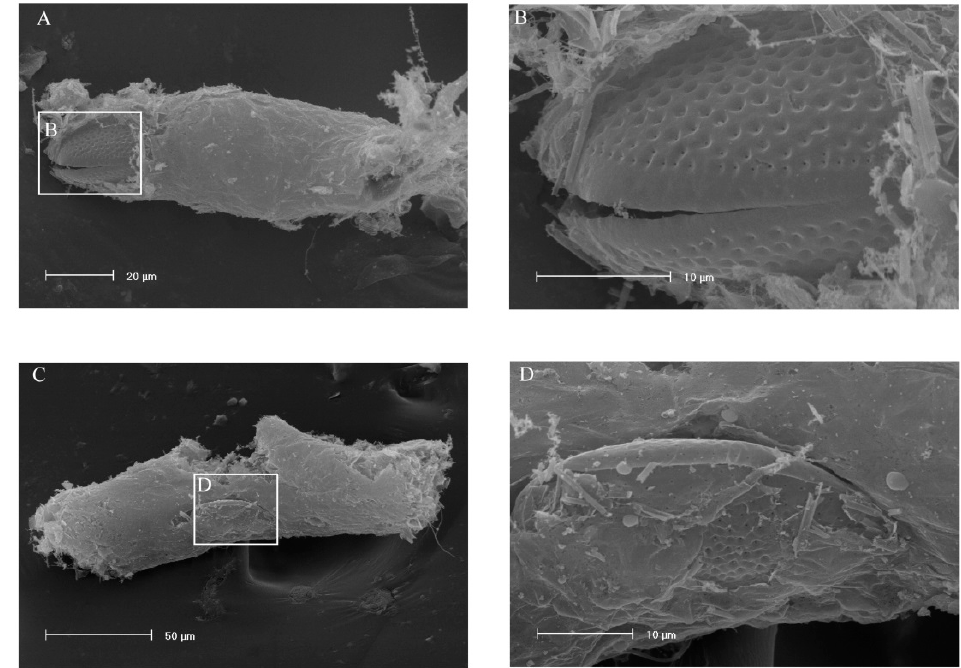
Figure 3. Scanning electron micrographs of A. clausi faecal pellets content collected in the Thermaikos Gulf. ( A , C ): faecal pellets covered partially with the peritrophic membrane showing a Dinophysis acuminata cell magnified in micrographs ( B , D ), respectively.